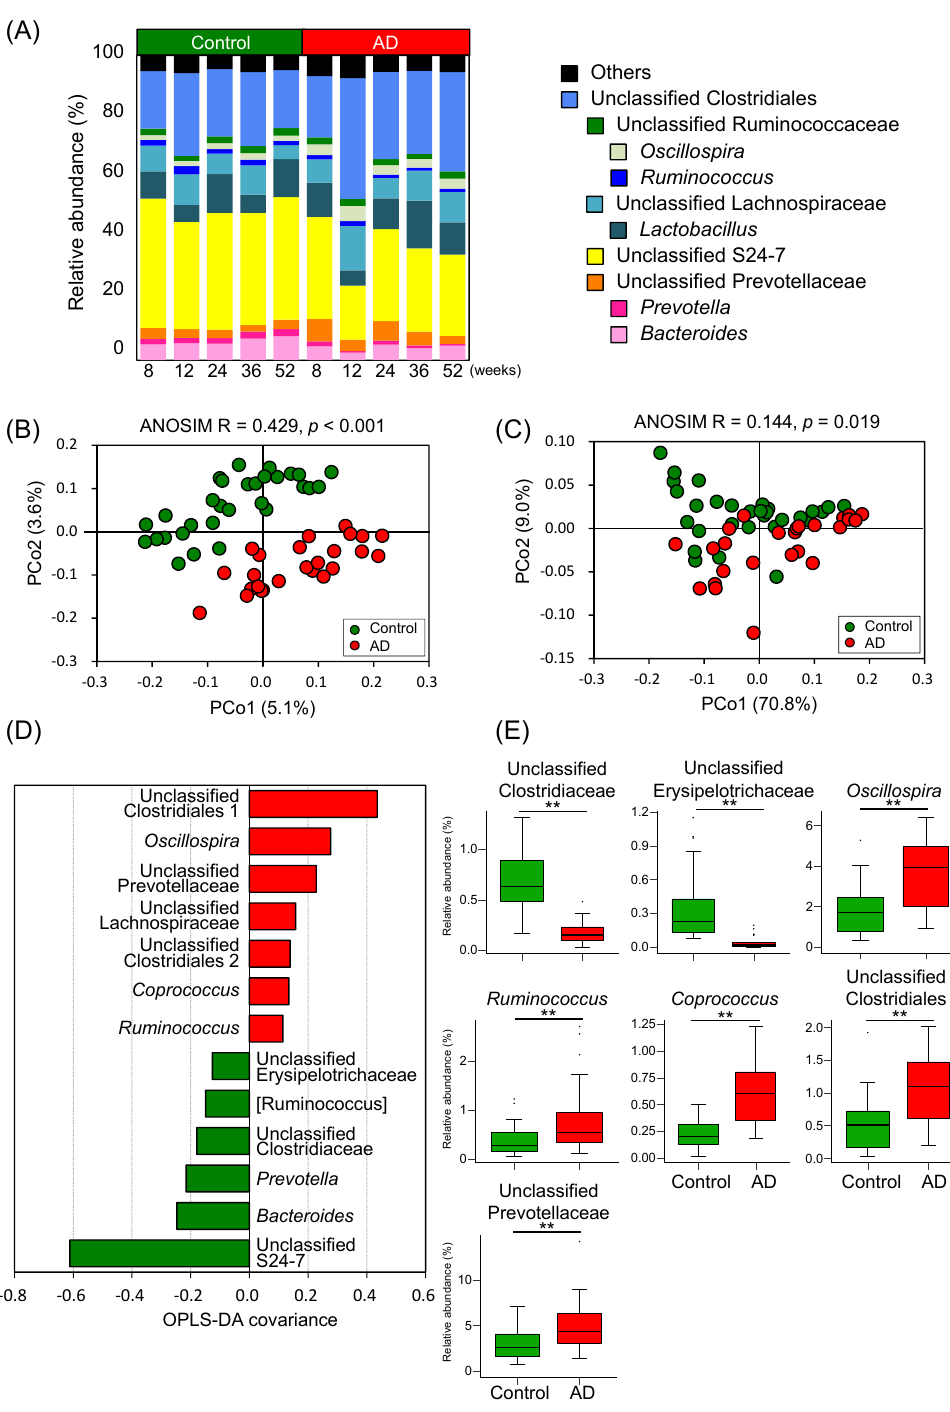
Figure 3. AD consumption alters intestinal microbiome profiles. ( A ) Bar graph showing the relative abundance of top 10 most-abundant genera (average abundance in all samples >1%) in control and AD mice; ( B ) Unweighted and ( C ) weighted UniFrac PCoA and ANOSIM comparing the intestinal microbiome profiles of control and AD mice; ( D ) Bar graph showing bacterial genera that had |OPLS-DA covariance| > 0.11 based on OPLS-DA of the microbiome profiles of control and AD mice. The model resulted in one predictive and one orthogonal four components with the cross-validated predictive ability Q2 (cum) = 0.832 and the total explained variance R2X (cum) = 0.918; ( E ) Box plots indicating relative abundance of genera that have |LDA score| > 2.0, |OPLS-DA covariance| > 0.11 in OPLS-DA, and FDR < 0.05 based on Mann–Whitney U test and Benjamini-Hochberg correction between the control and AD groups. Significant differences are indicated by * FDR < 0.05, ** FDR <